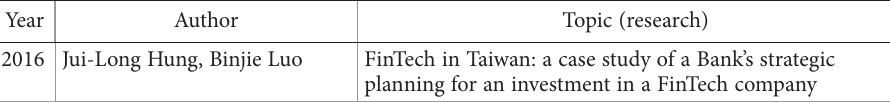
Table A1. Research on the topic of FinTech (source: